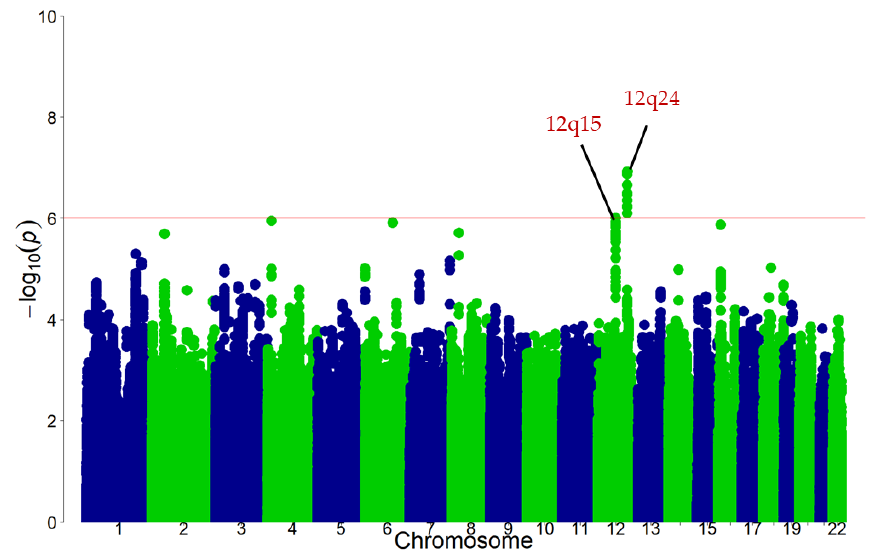
Figure 3. Manhattan plot for the discovery GWAS of habitual black tea consumption in the Japanese population. Single nucleotide polymorphism (SNPs) are ordered by chromosome and position in the x -axis. The y -axis shows the negative logarithm of the association of each SNP with black tea consumption. The red line represents p < 1.0 × 10 −6 . GWAS: genome-wide association study.